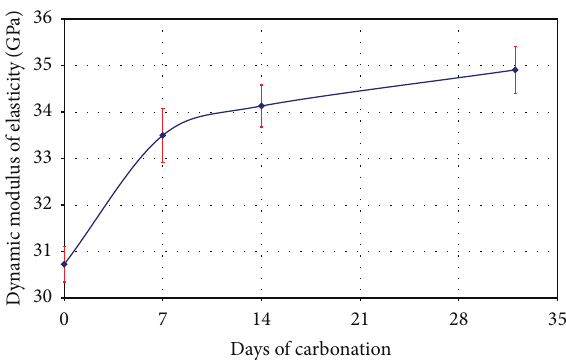
Figure 16: Evolution of the dynamic modulus of elasticity during carbonation.